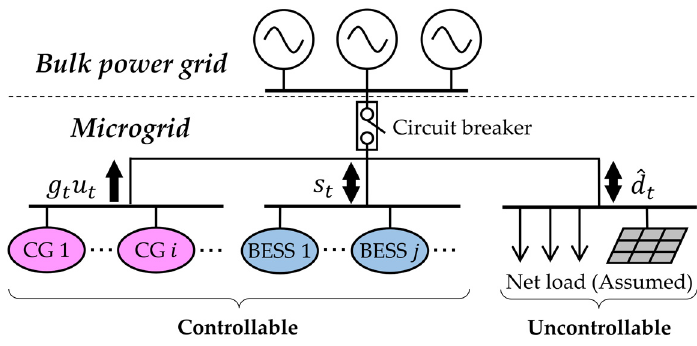
Figure 1. Conceptual illustration of a